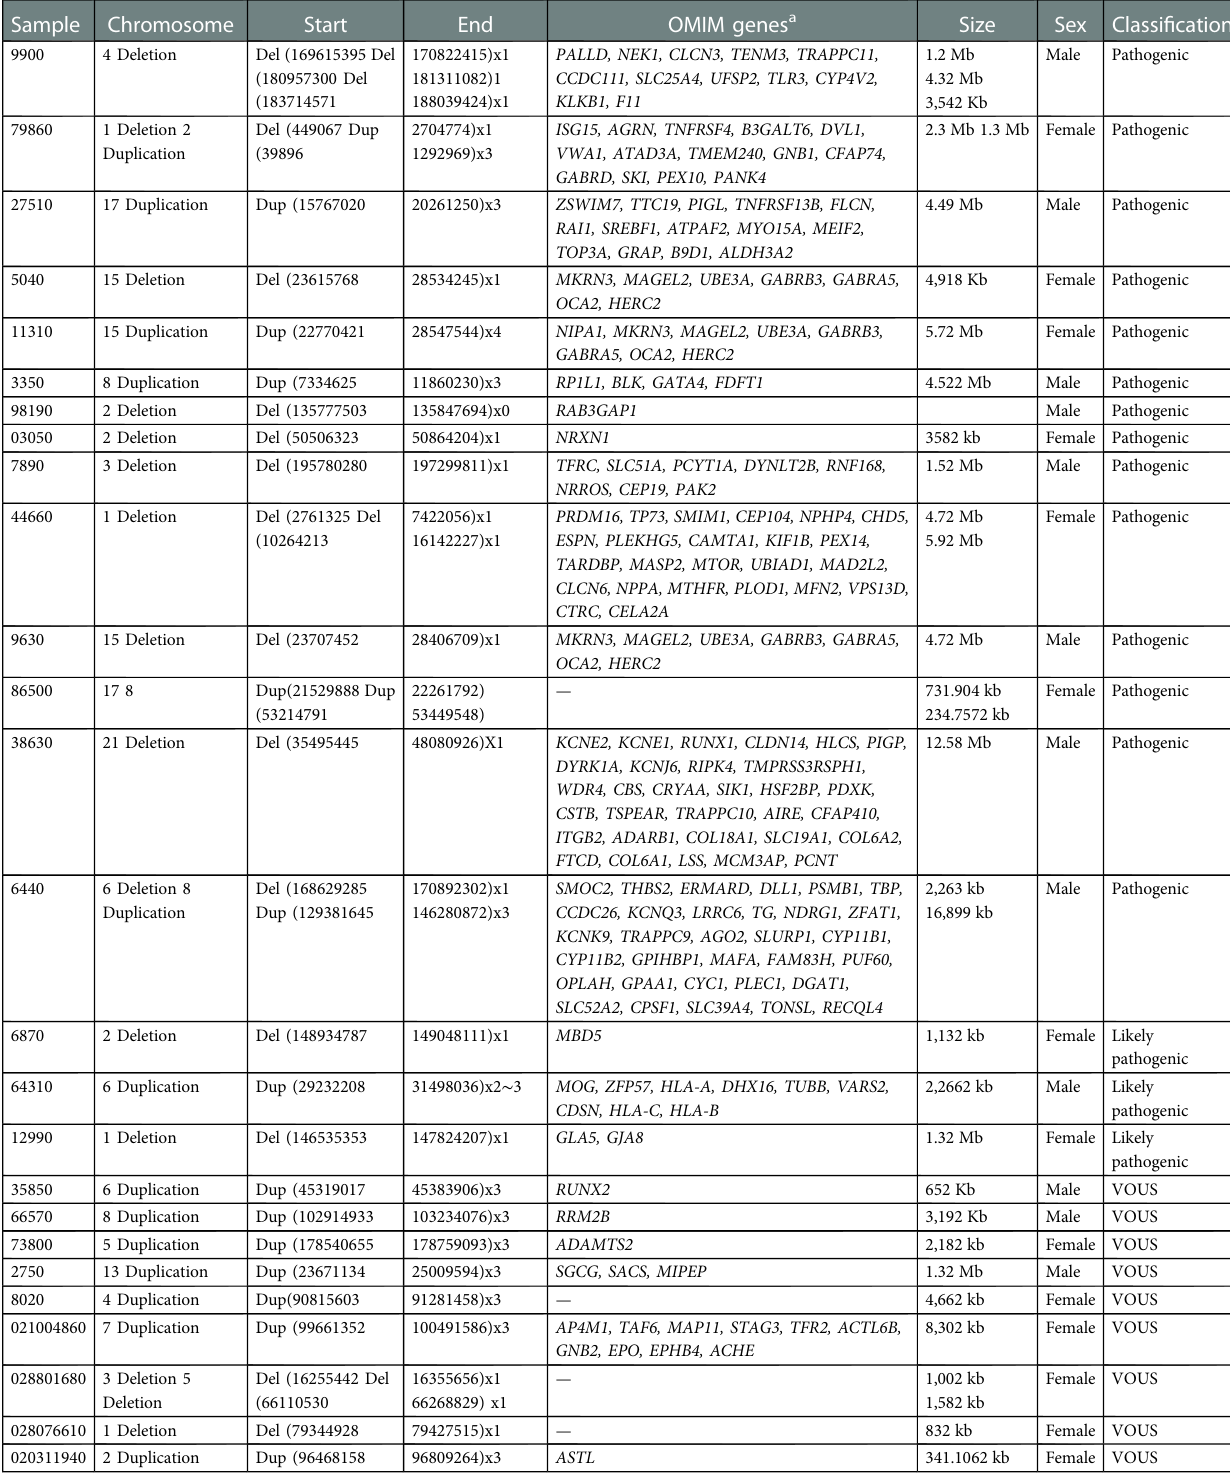
TABLE 3 CNV variants found in